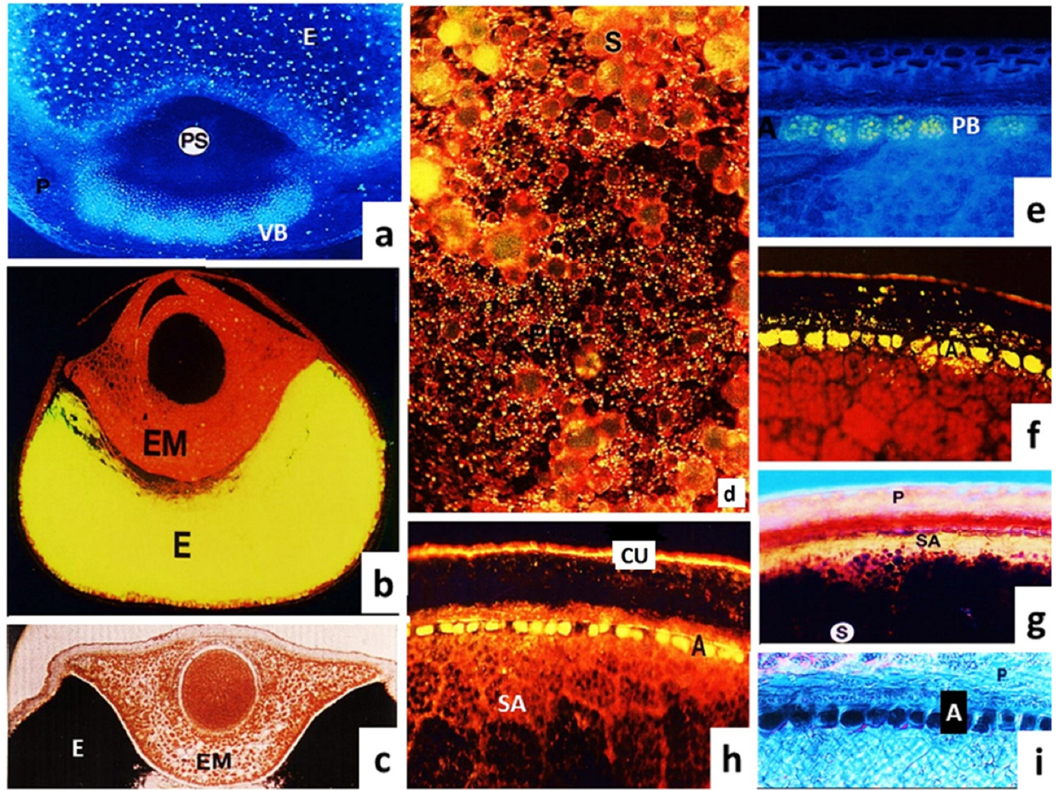
Figure 5. (a-i) Localization of nuclei, protein and lipids (a) T. S. of caryopsis 15 DAF stained with 4,6-diamidino-2-phenylindole (DAPI), excited with UV light showing densely packed nuclei in the vascular parenchyma and cells, and distribution of triploid nuclei in endosperm. 100x. (b) Free-hand T.S. of caryopsis stained with Coriphosphine and excited with blue light. Starch in endosperm fluoresces yellow while lipids in embryo fluoresce in orange-red. 40x. (c) Mature caryopsis simultaneously stained with I 2 KI and Sudan IV showing distribution of starch in endosperm and lipids in embryo. 30x. (d) Smear from 25-day-old endosperm stained with Acridine Orange and excited with blue light. Protein bodies fluoresce yellow-green; larger starch grains appear greenish. 400x. (e) Protein bodies (aleurone grains) in aleurone cells stained with Barbituric Acid and excited with UV light. 180x. (f) Lipids in aleurone cells fluoresce yellow when stained with Nile Blue A and excited with blue light. 180x. (g) Free-hand T.S. of cv. ‘Framida’ stained with I 2 KI, viewed in Nomarski DIC mode. Starch is present in endosperm. Two layers of sub-aleurone rich protein bodies show no evidence of starch. 150x. (h) Free-hand T.S. of mature caryopsis stained with Nile Red, excited with blue light. Lipid in aleurone cells and cuticular layers of outer and inner pericarp all fluoresce in yellow. 170x. (i) Lipids in aleurone cells stained with Sudan Black, photographed in DIC mode.